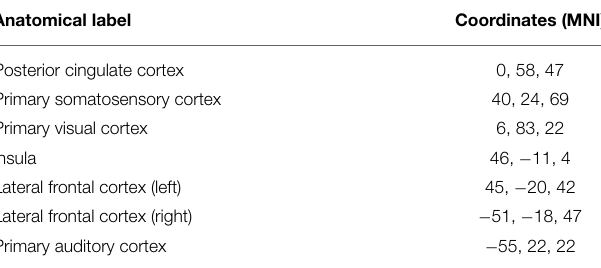
TABLE A1 | Spatial localization in MNI space coordinates of seed regions used for Figure 3. Anatomical